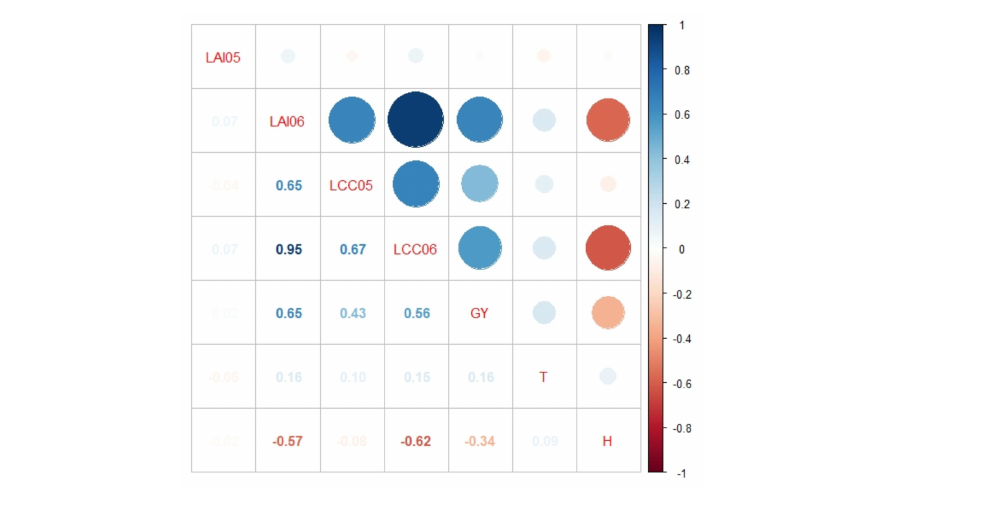
Figure 10. Correlation analysis of studied traits: LAI05, LAI06, LCC05, LCC06, grain yield (GY), tillering (T), and plant height (H). Data from both CVTs are used. Only significant correlations ( p < 0.05) are shown.